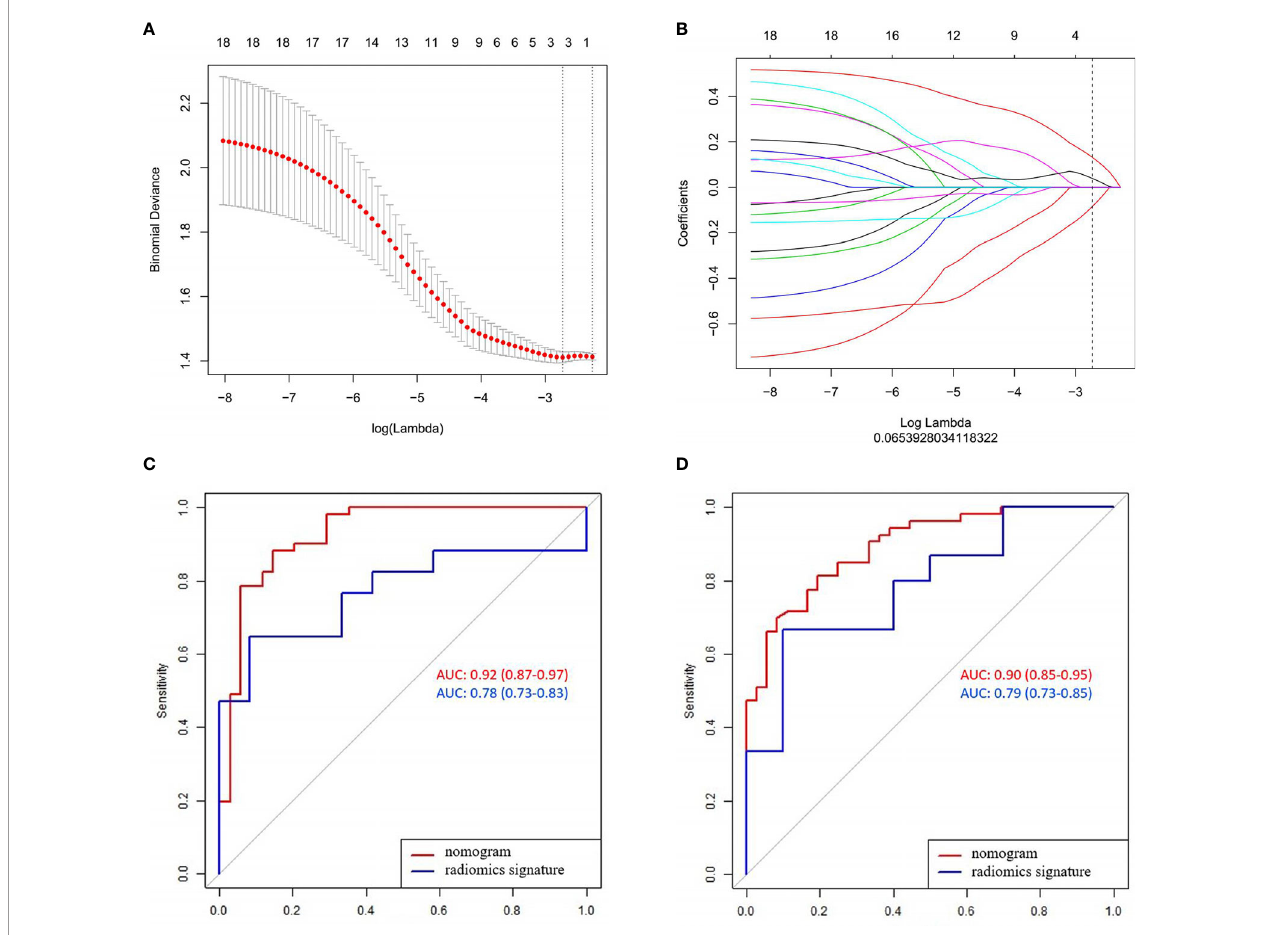
FIGURE 2 | LASSO algorithm for radiomics feature selection and the predictive performance of the radiomics. (A) Mean square error path using 10-fold cross validation; (B) LASSO coef fi cient pro fi les of the radiomics features; and (C, D) ROC curves of the radiomics signature and nomogram in the training and validation